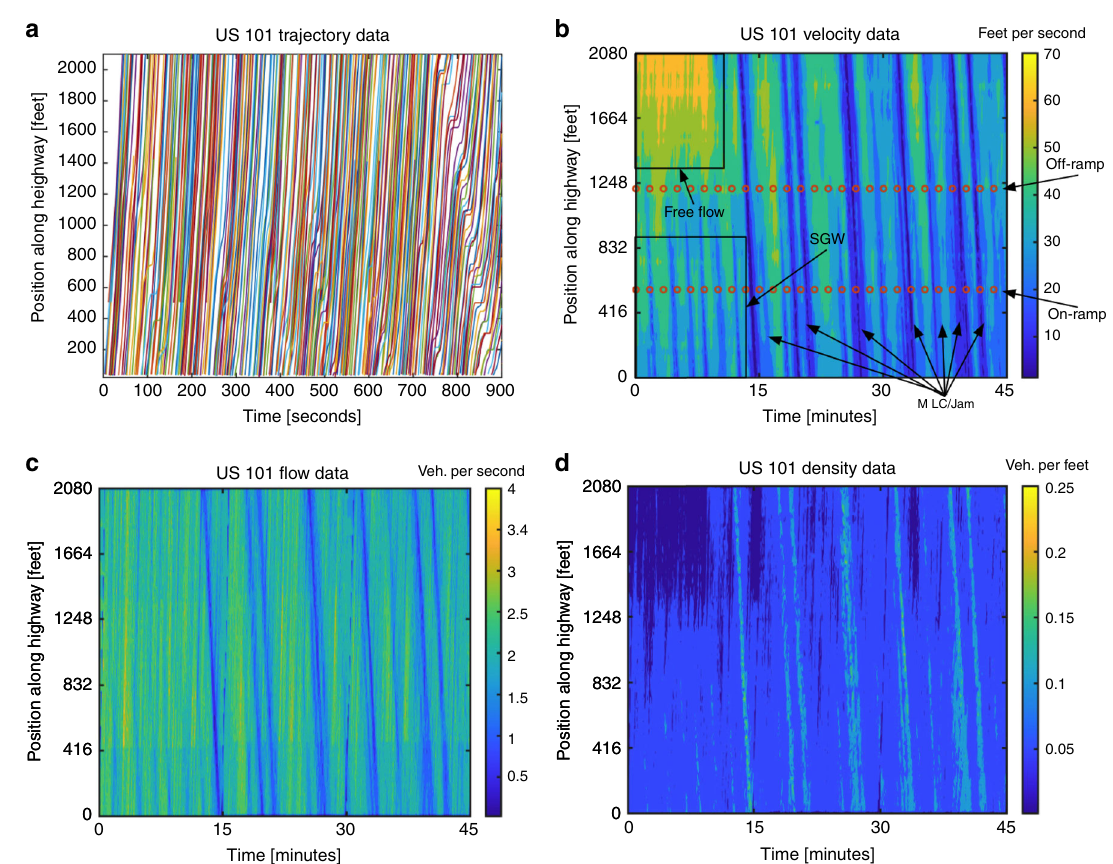
Fig. 1 Spatiotemporal data for the US-101 highway obtained from binning the NGSIM trajectory data. a Plot of the trajectory data for the fi rst 15 min. The data was collected between the hours of 7:50 am and 8:35 am, during the onset of congestion. The section of the highway studied consists of fi ve main lanes, a single on and off-ramp and an auxiliary lane between the on and off-ramp. Every colored line corresponds to a unique vehicle. b Spatiotemporal velocity data. The locations of the ramps have been labeled with dark-orange dotted lines. During the fi rst 12 min, the post-off-ramp section of the highway experiences a period of free- fl owing traf fi c. However, during this same time, the mid and pre-on-ramp sections of the highway are experiencing stop and go wave traf fi c, labeled as SGW. During the last 30 min of the study, the highway experiences a series of moving localized clusters labeled MLC, which correspond to traf fi c jams. c Spatiotemporal fl ow data. The fl ow data is obtained as the product of the velocity and density data sets. d Spatiotemporal density data. As expected, the density appears to be related to the inverse of the velocity pro fi le. Speci fi cally, one can observe that periods corresponding to free- fl owing traf fi c have smaller density and periods corresponding to traf fi c jams are a result of high density. The source data underlying ( b – d ) are provided in the Source Data fi